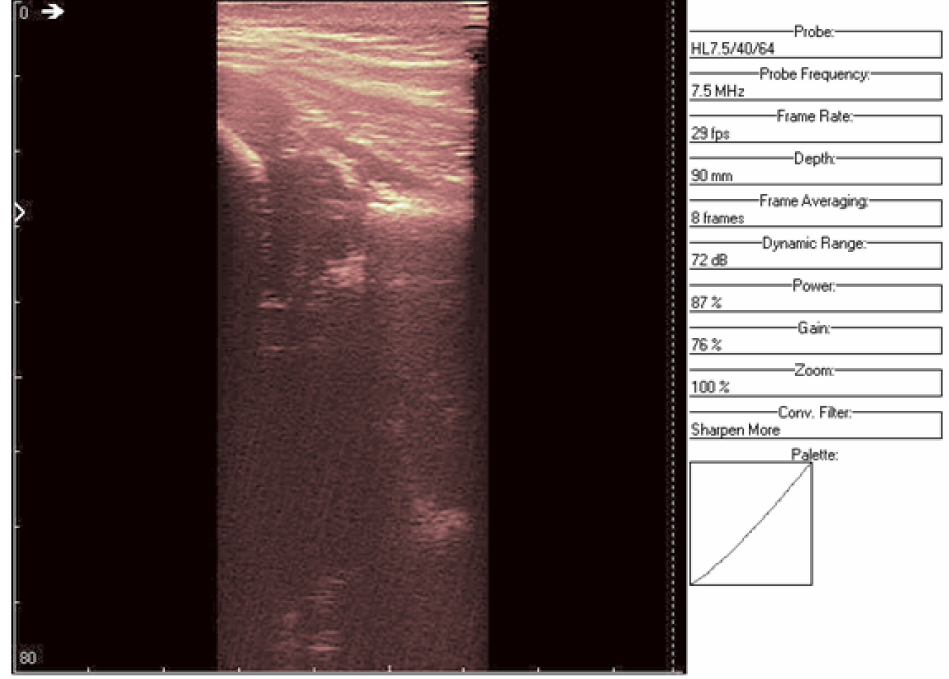
Figure 11. Original data, Image 3, with added color palette.